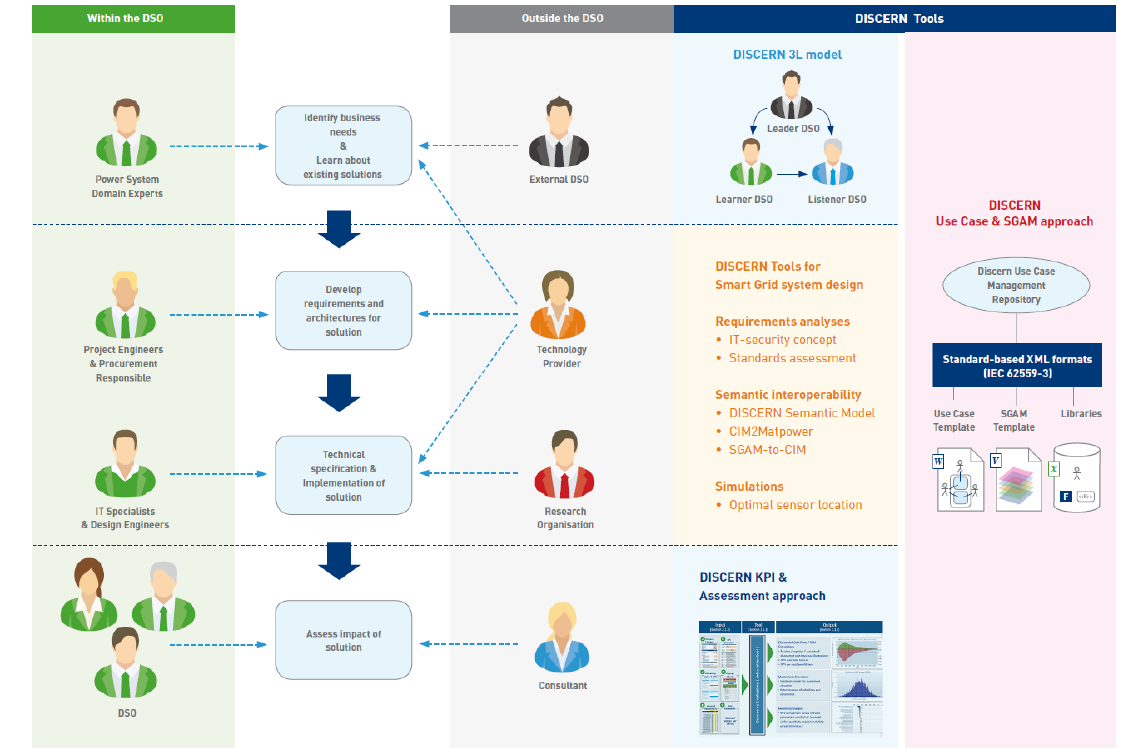
Figure 7. Overview on DISCERN concept for modeling solutions for 3L